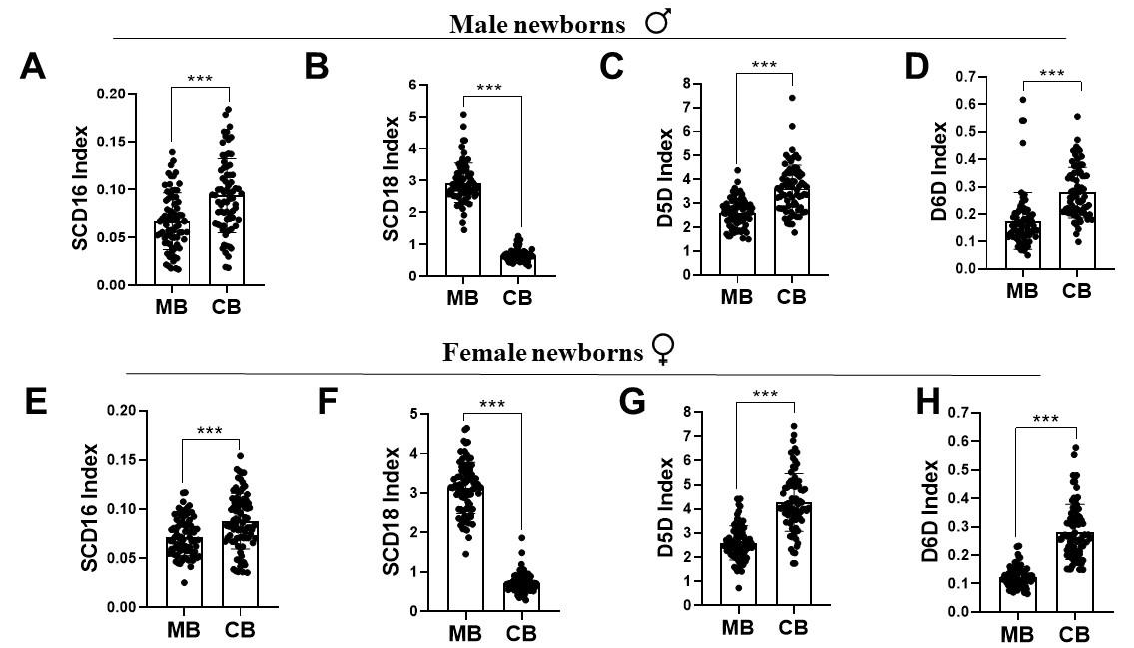
Figure 2. Bar graphs representing average estimated fatty acid desaturation indices (ratio of product by precursor fatty acid) from plasma fatty acid composition quantified by gas chromatography of MB and CB in the human cross-sectional study. ( A – D ) SCD desaturation indices of carbon 16 and 18 as SCD16 (C16:1/C16), SCD18 (C18:1/C18), delta-5-desaturases (C20:4/C20:3, D5D) and delta-6-desaturases (C20:3/C18:2), D6D) indices in the MB and CB of male newborns. ( E – H ) SCD16, SCD18, D5D and D6D indices in MB-CB of female newborns. MB < CB for SCD16, D5D and D6D indices and MB > CB for SCD18 index in the male and female newborns. *** p < 0.001 indicates significance between the compared groups. MB, plasma of mother blood; CB, plasma of cord blood; SCD, stearoyl CoA desaturase; D5D, delta-5-desaturase; D6D, delta-6-desaturase.